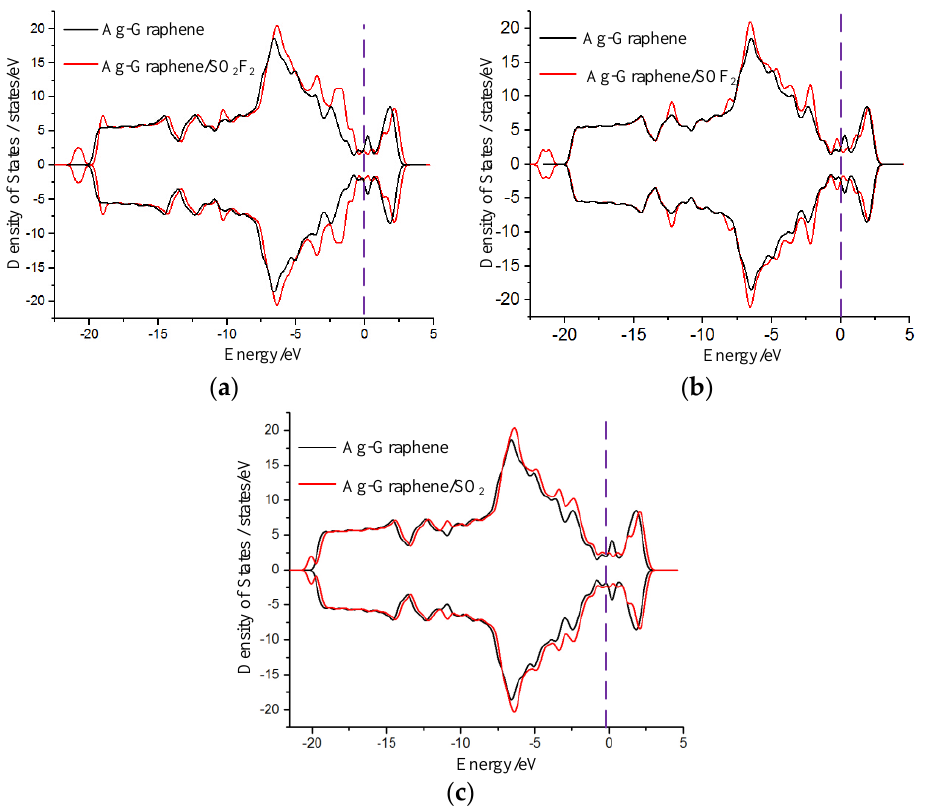
Figure 6. DOS for Ag-graphene with and without single-molecule adsorption in ( a ) SO 2 F 2 ; ( b ) SOF 2 ; and ( c ) SO 2 .